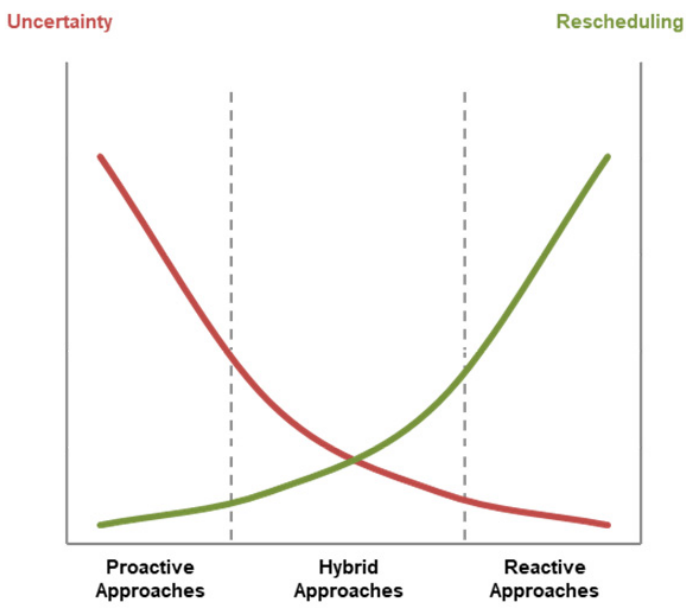
Figure 1. Classification according to uncertainty and rescheduling capabilities.